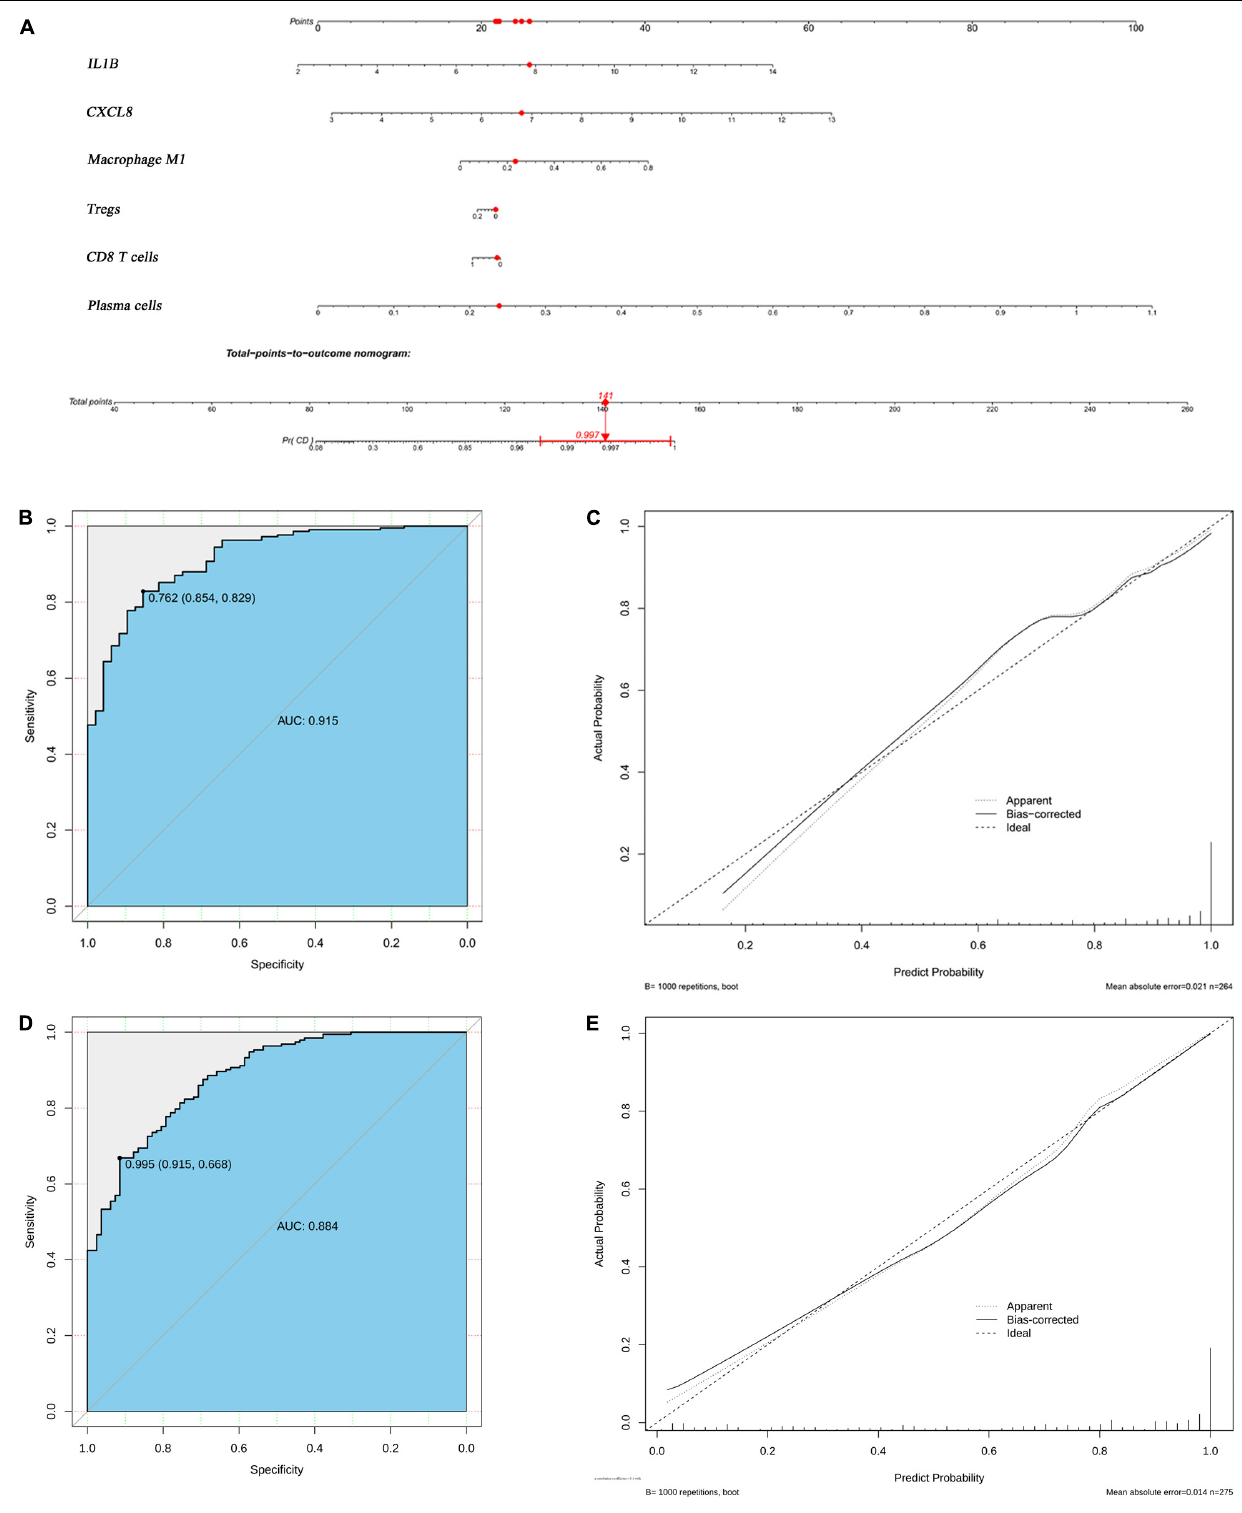
Frontiers in Genetics |